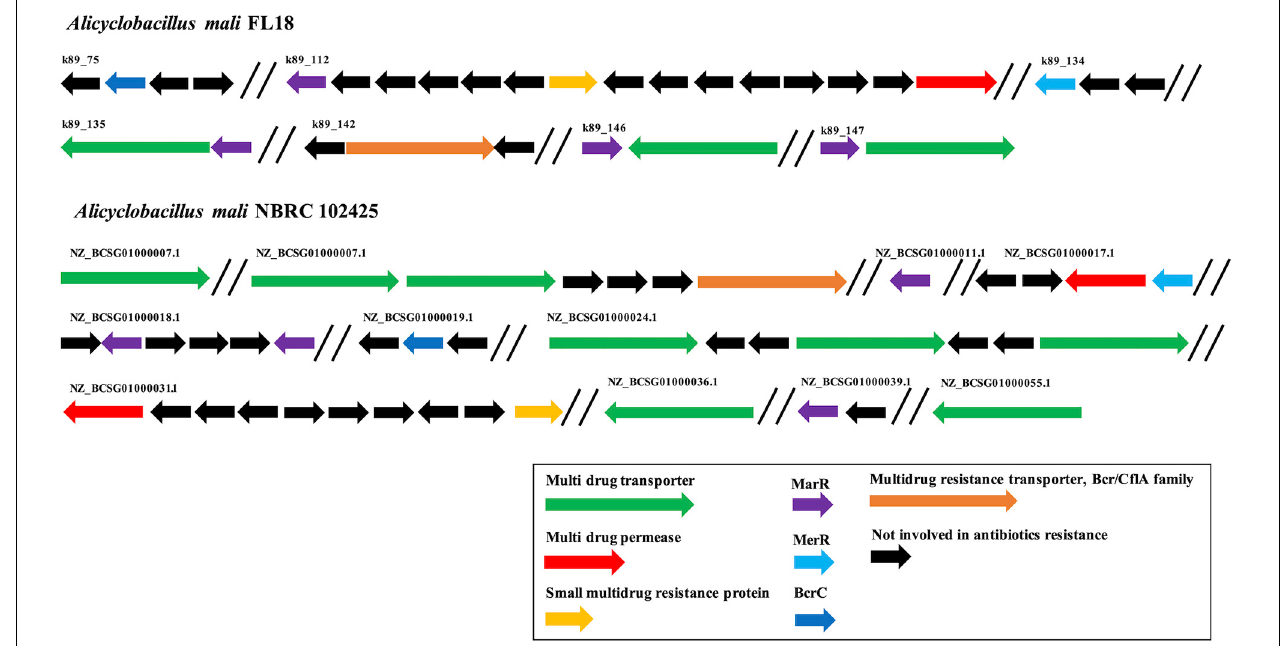
FIGURE 7 | Organization of multi-drug resistance genes. Comparison of antibiotic resistance genes in A. mali FL18 (Up) and A. mali NBRC 102425 (Down) . In purple, MarR genes coding for antibiotic responsive transcriptional regulator; in blue, MerR gene coding for mercury resistance transcriptional regulator; in green, multidrug transporter genes; in red, multidrug permease genes; in orange, small multidrug resistance protein; in black, genes that are not involved in antibiotic resistance.